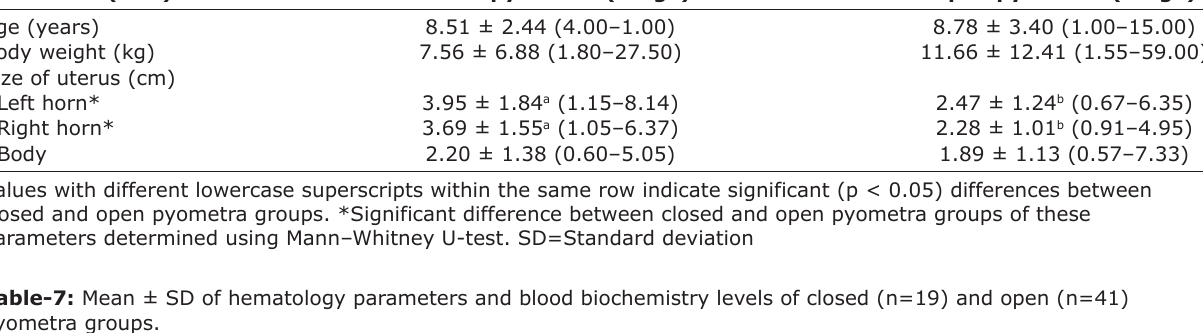
Table-6: Mean ± SD of age, bodyweight, and size of uterus of closed (n = 19) and open (n = 41) pyometra groups. Parameter